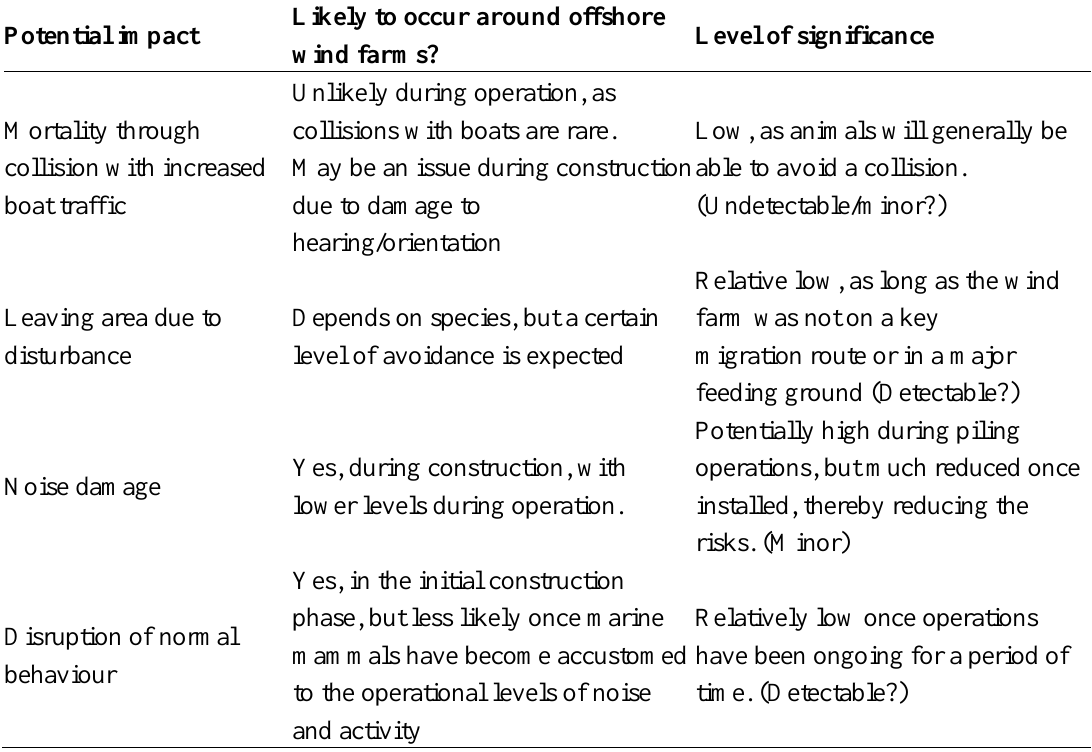
Table 7. Potential impacts of offshore wind farms: marine mammals (modified from Wilson